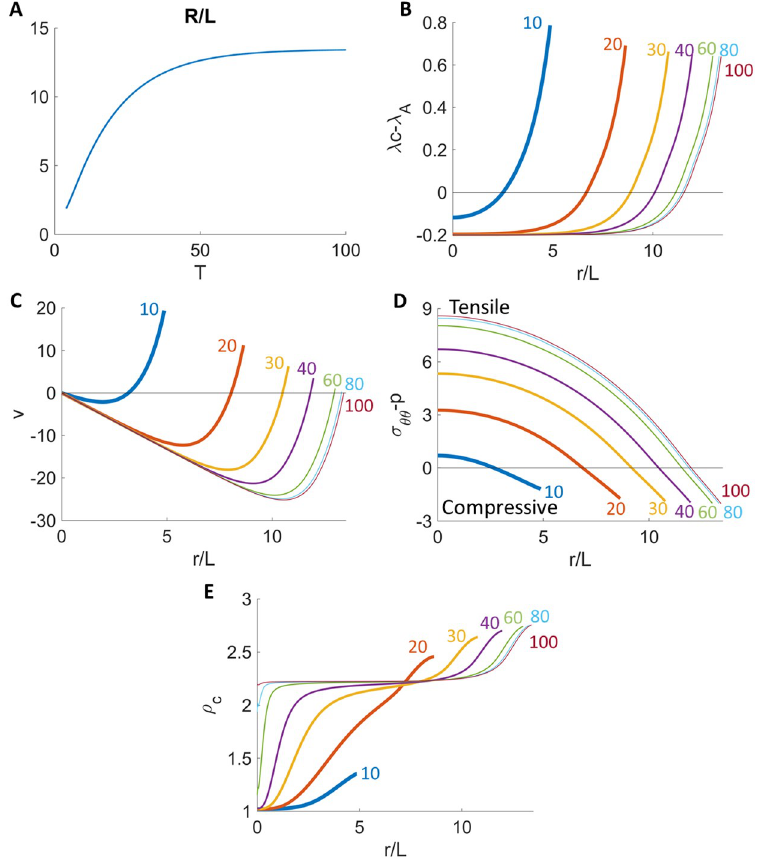
Fig 1. Time evolution of a freely growing tumor without external compression (A). The spatial distribution of net volumetric growth rate (B), cell velocity (C), circumferential stresses (D), and cell density (E) at different times. See S1 Text for the list of